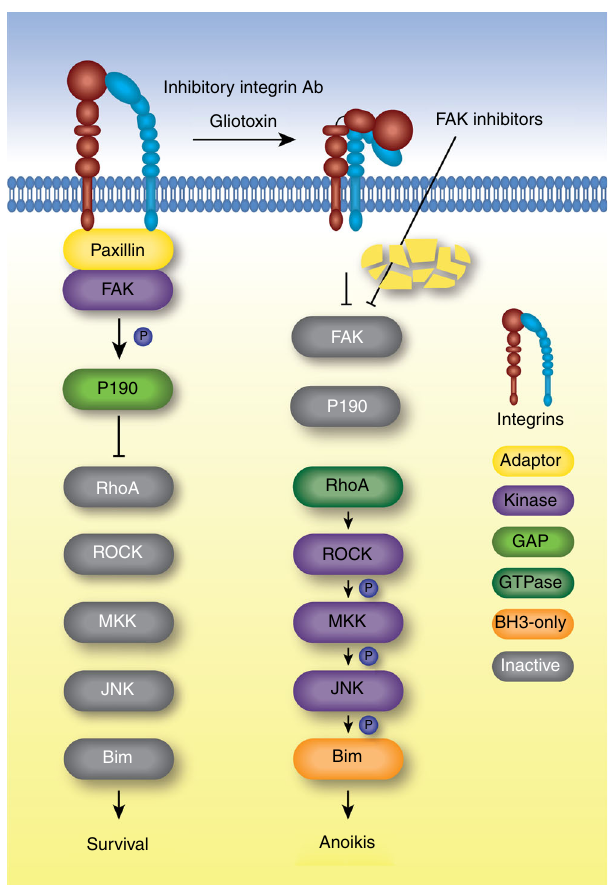
Fig. 8 GT-induced anoikis signalling. FAK is recruited to focal adhesions via paxillin and is active in healthy adhesion cells. Active FAK phosphorylates p190RhoGAP. Phosphorylated p190RhoGAP stimulates the GTPase activity of RhoA. RhoA and the downstream anoikis-inducing cascade is therefore inactive (left). GT inactivates integrins, possibly by covalent binding to cysteines in the N-terminal region of α and β chains and triggers the disassembly of focal adhesions. Paxillin is degraded and FAK is inactivated, resulting in inactive p190RhoGAP. RhoA is consequently active and